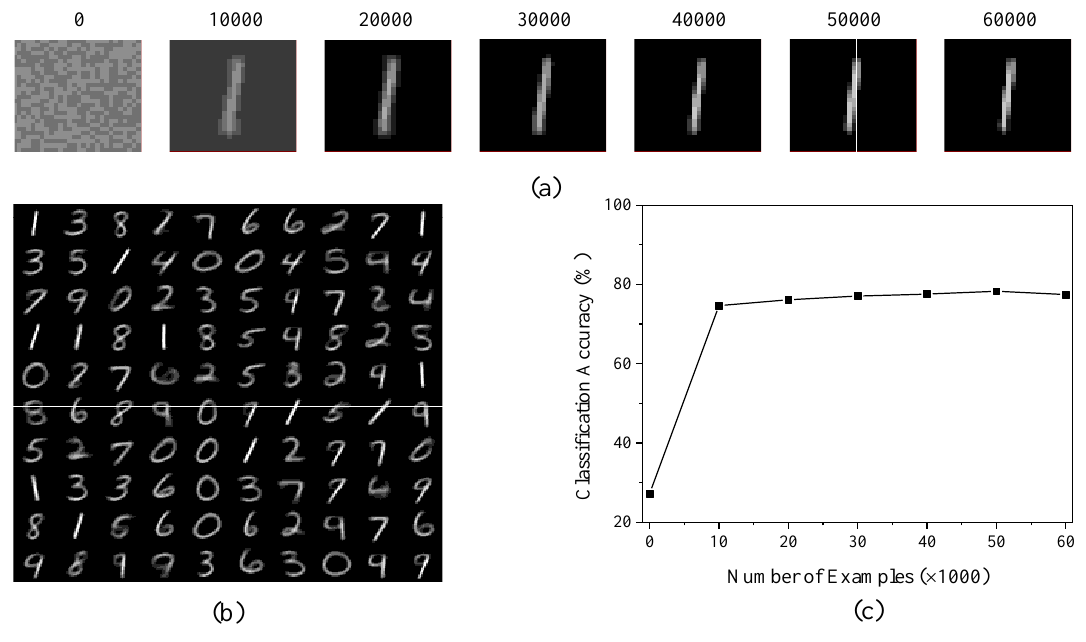
Figure 4. ( a ) Evolution of the learned feature, ( b ) Features learned after applying the whole training set, ( c ) impact of the number of training examples on classification